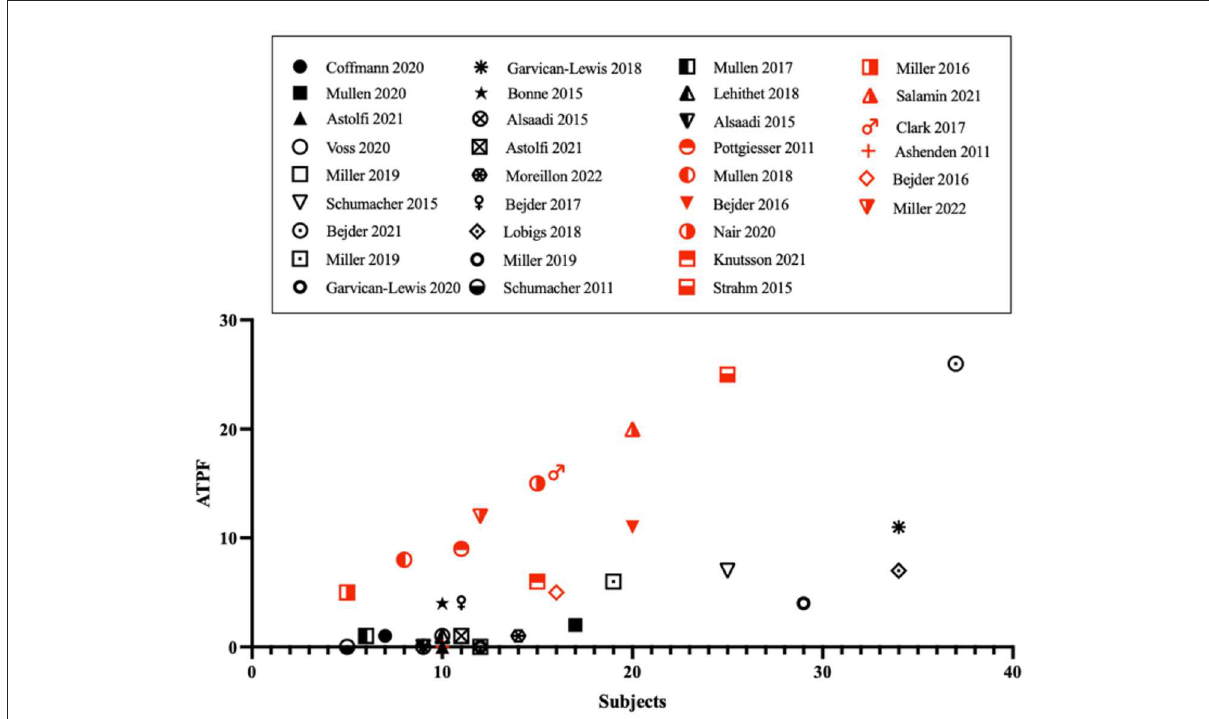
FIGURE1 Occurrences of atypical passport findings (ATPF) as function of the number of subjects in the studies that used the official Anti-Doping Administration and Management System (ADAMS) training software. Publications involving doping protocols are presented with red symbols, publications investigating confounding factors in black